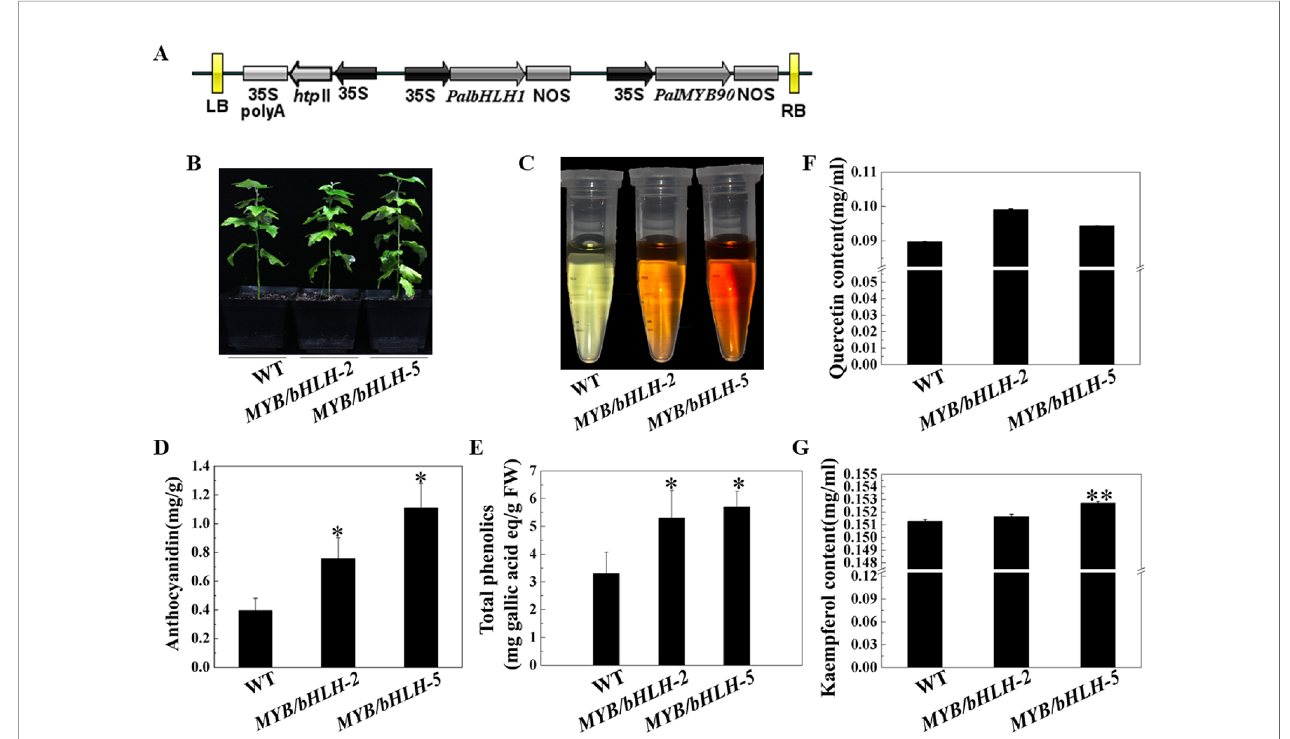
FIGURE 2 | Characterization of transgenic poplar plants. (A) Construction of the MYB90 / bHLH1 -OE plasmid. (B) Growth of transgenic ( MYB90 / bHLH1 -OE) and wild-type (WT) poplar plants. (C) Color of anthocyanin extraction. (D) Accumulation of total anthocyanins in the leaves of MYB90 / bHLH1 -OE and WT plants. (E) Accumulation of total phenolics in the leaves of MYB90 / bHLH1 -OE and WT plants. (F , G) Contents of quercetin and kaempferol in the leaves of MYB90 / bHLH1 - OE and WT poplar plants, respectively. The leaves of 2-month-old poplar grown in pots were used in these experiments. Error bars indicate ± SE. Asterisks (*) indicate signi fi cant differences, P < 0.05. Asterisks (**) indicate signi fi cant differences, P ≤